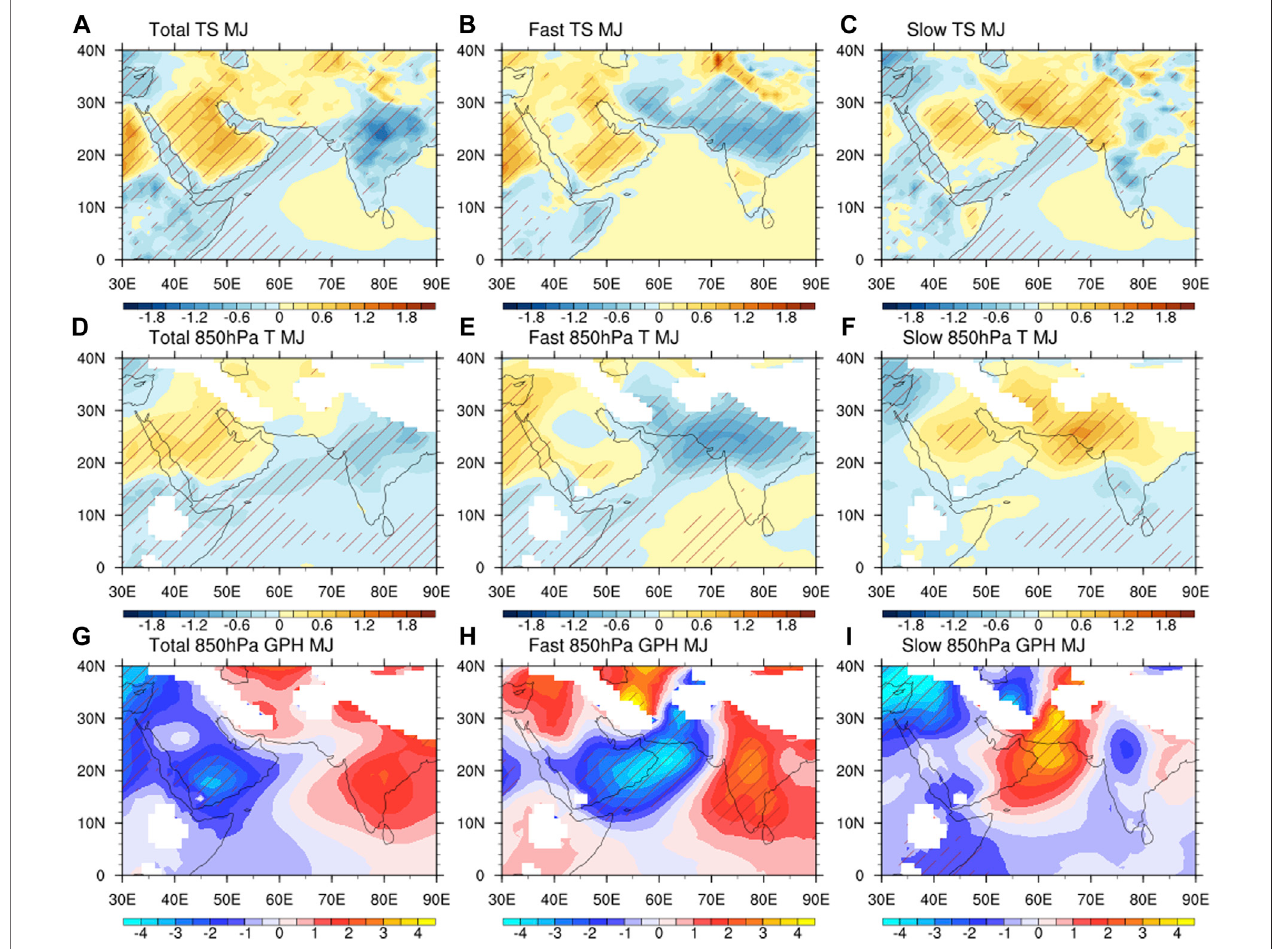
FIGURE 9 | The total [ (A,D,G) , CMD − CMN], fast [ (B,E,H) , UMD − UMN] and slow [ (C,F,I) (CMD − CMN) − (UMD − UMN)] responses of temperature at the surface (A – C;k) and 850 hPa (D – F,K) as well asthose of geopotential height ( G – I , gpm) at 850 hPa to the dust DRE during the early monsoon season (May – June).Brown lines represent the values statistically signi fi cant at the 0.1